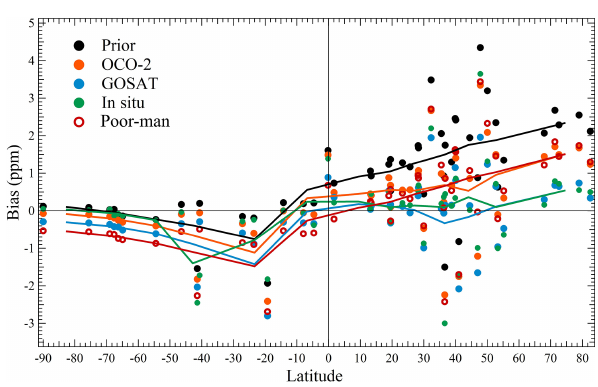
Figure 3. Biases of the simulated CO 2 mixing ratios against the flask measurements at different latitudes (positive–negative biases represent a modeled concentration greater–less than the observed, and the different colored lines represent the smoothing of the corre- sponding